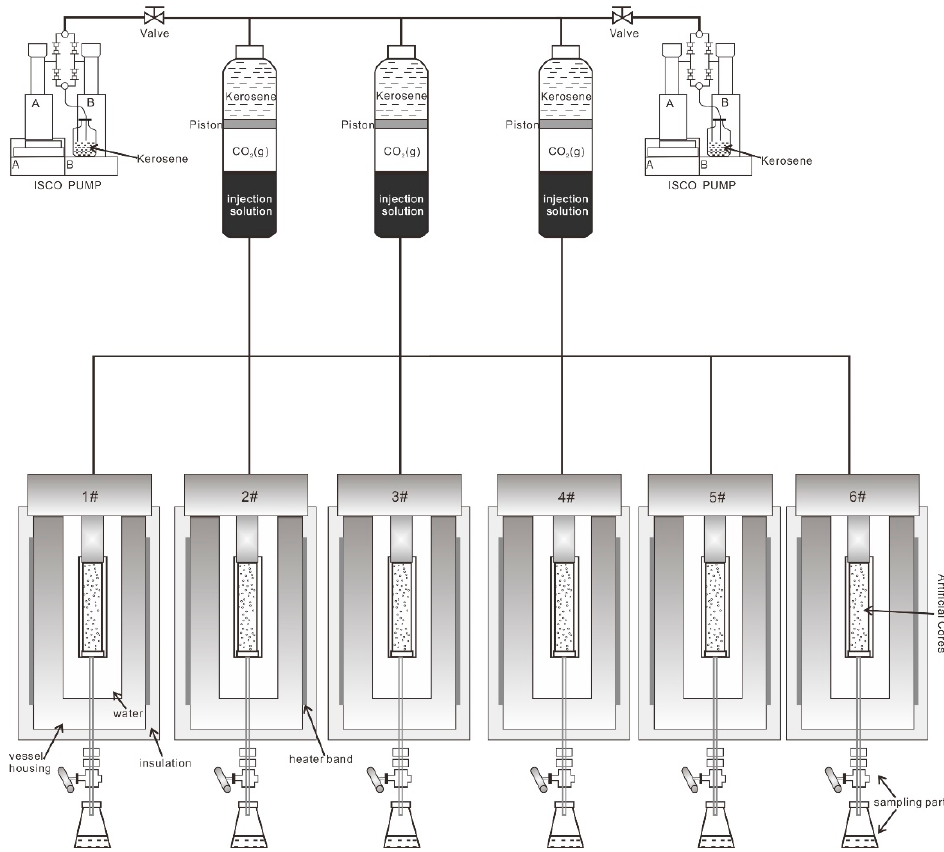
Figure 1. Schematic diagram of CO 2 -formation water-rock physical experiment.